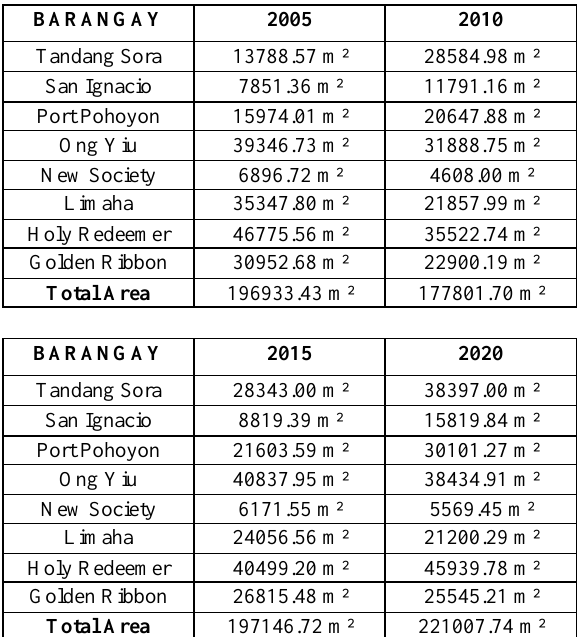
Table 10. Total Areas of Major Informal Settlements